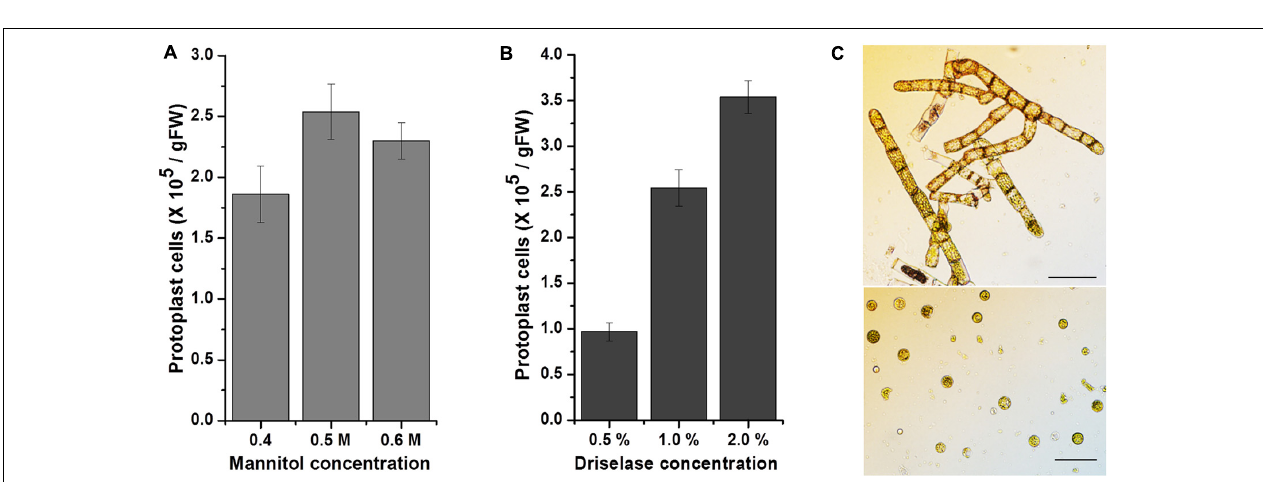
FIGURE 3 | Molecular phylogenetic analysis of KMR5045. Amplified rps4 and trn L-F sequences were aligned with sequences from other mosses and analyzed using the neighbor-joining method. The phylogenetic tree shows that KMR5045 is closely related to Bryum wrightii .